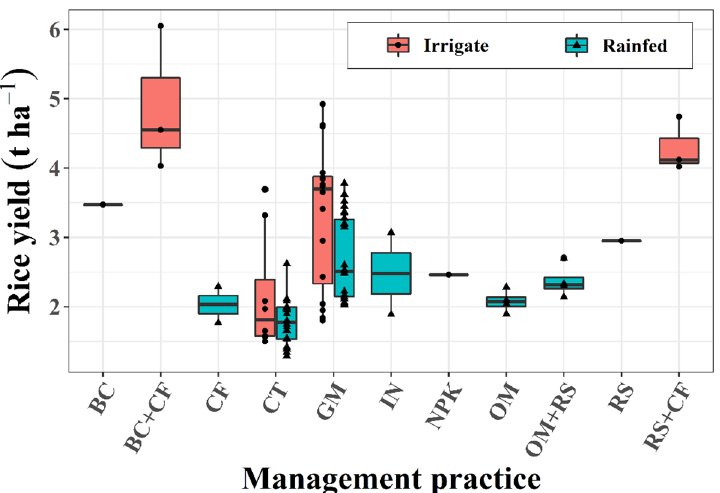
Figure 6. An overview of rice yield in relation to management practice at the rice paddies of Northeast Thailand ( n = 89) (within the range of 0–40 cm depth) [41,49–70]. * BC = biochar, CF = chemical fertilizer, CT = control, GM = green manure, IN = intercropping, NPK = nitrogen, phosphorus, and potassium fertilizers, OM = organic material, RS = rice straw.